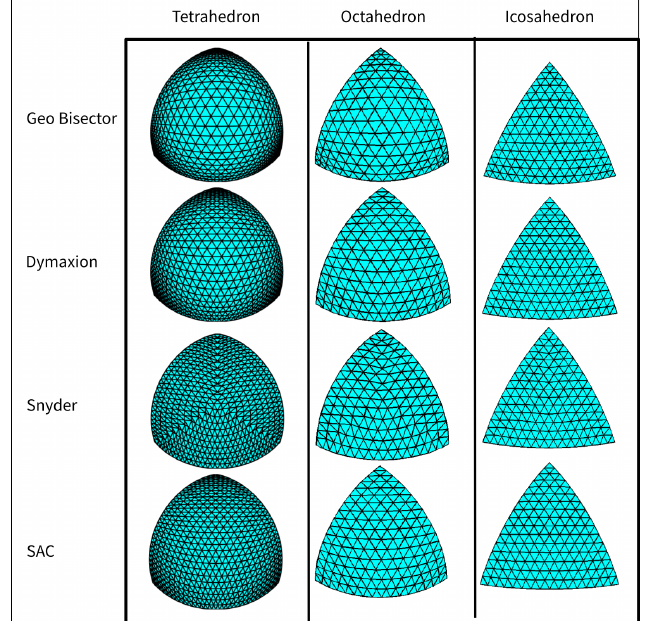
Figure 17. The four polyhedral DGGSs. Each figure shows a 4-fold, level-5 triangle subdivision on polyhedrons. The surfaces are shown in an orthographic projection to accentuate the distortion patterns present in each method.